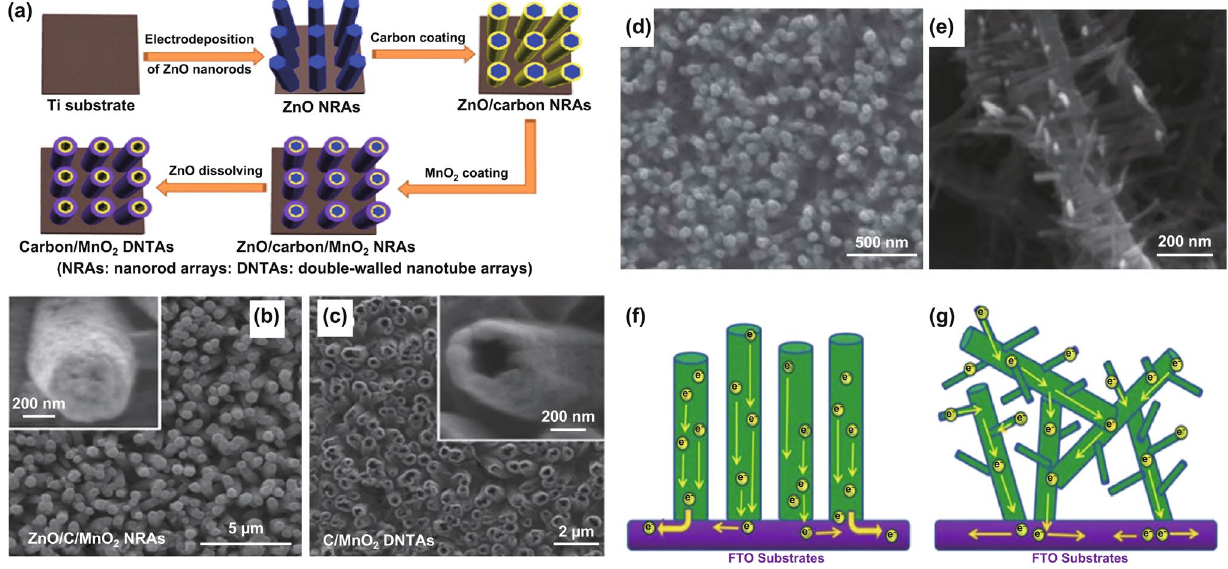
Fig. 18 a Schemes of the synthesis procedures of double‑walled MnO 2 nanotube arrays on carbon cloth. b SEM image of ZnO/C/MnO 2 nanorod arrays. Inset: Magnified view of a single nanorod. c SEM image of C‑coated MnO 2 double‑walled nanotubes. Inset: Magnified view showing a C‑coated MnO 2 nanotube. d , e SEM images of MnO x d nanorods and e herringbones. f , g Schemes of the charge transfer pathways in f MnO x nanorod arrays and g MnO x herringbones. Adapted from a – c Ref. [173] and d – g Ref. [180] with